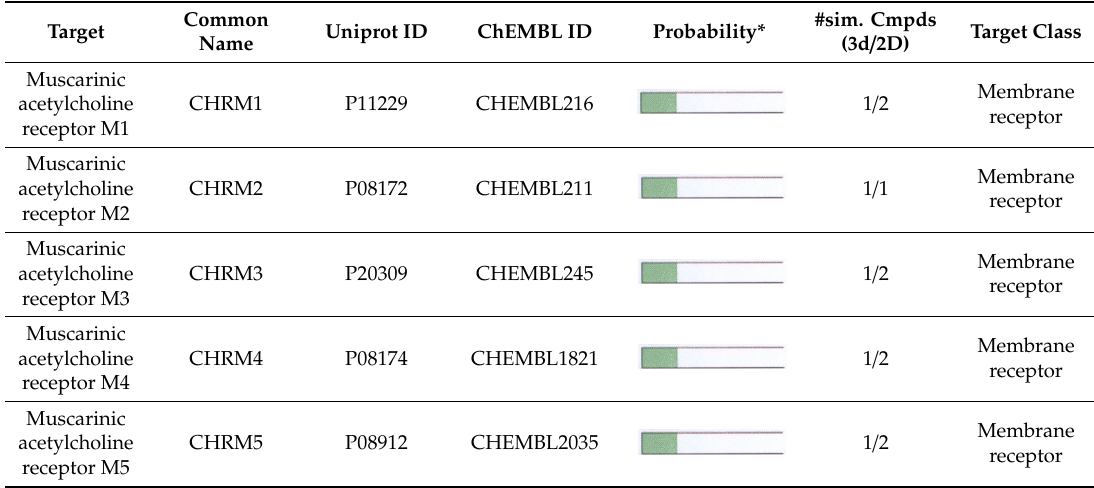
Table 3. Hermidin targets obtained by computational modelling using Swiss Target Prediction Software.